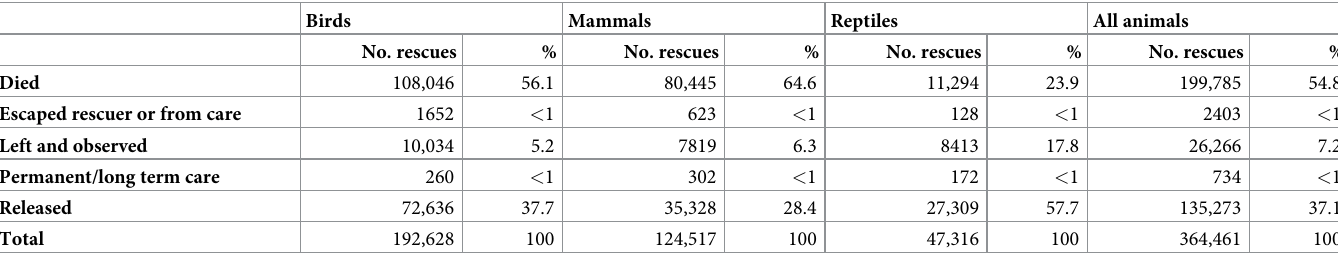
Table 8. Fate of animals for each taxonomic group, shown as the number of rescues and the percent of rescues within group. Birds Mammals Reptiles All animals No. rescues % No. rescues % No. rescues % No. rescues % 108,046